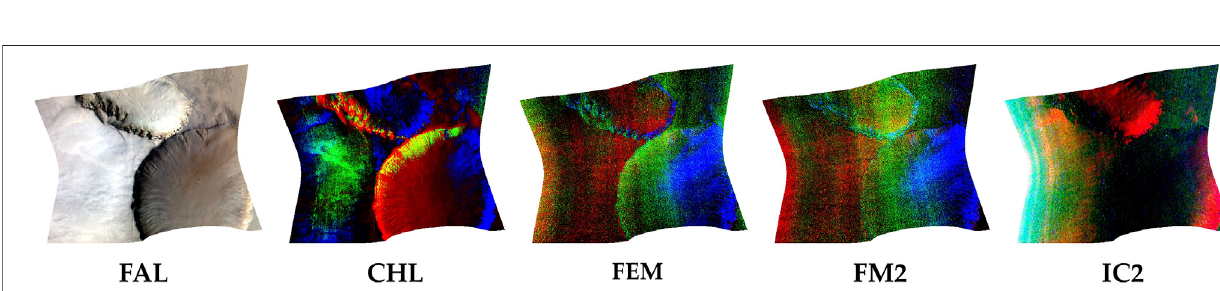
Frontiers in Astronomy and Space Sciences |